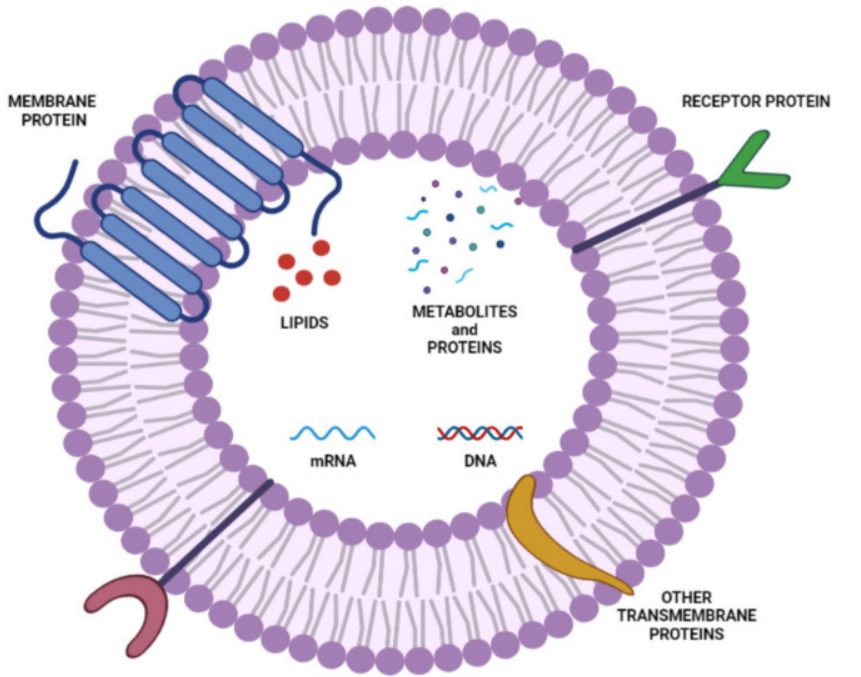
Figure 7. Exosome structure and content. Created with BioRender.com (accessed on 10 January